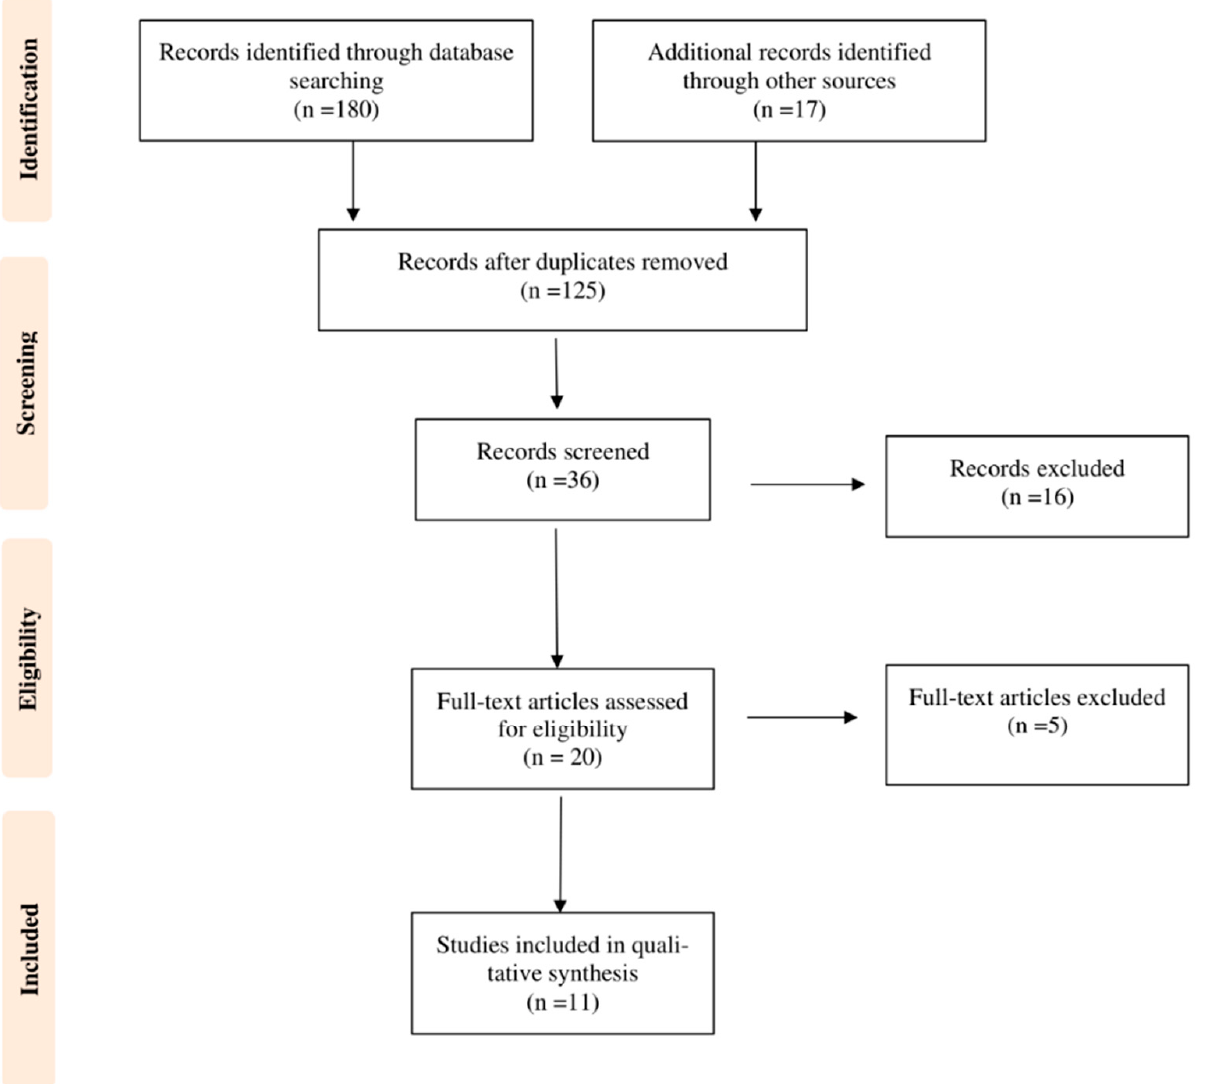
Figure 1. Preferred Reporting Items for Systematic Reviews and Meta-analyses (PRISMA) flow chart illustrating the number of studies at each stage of the review.